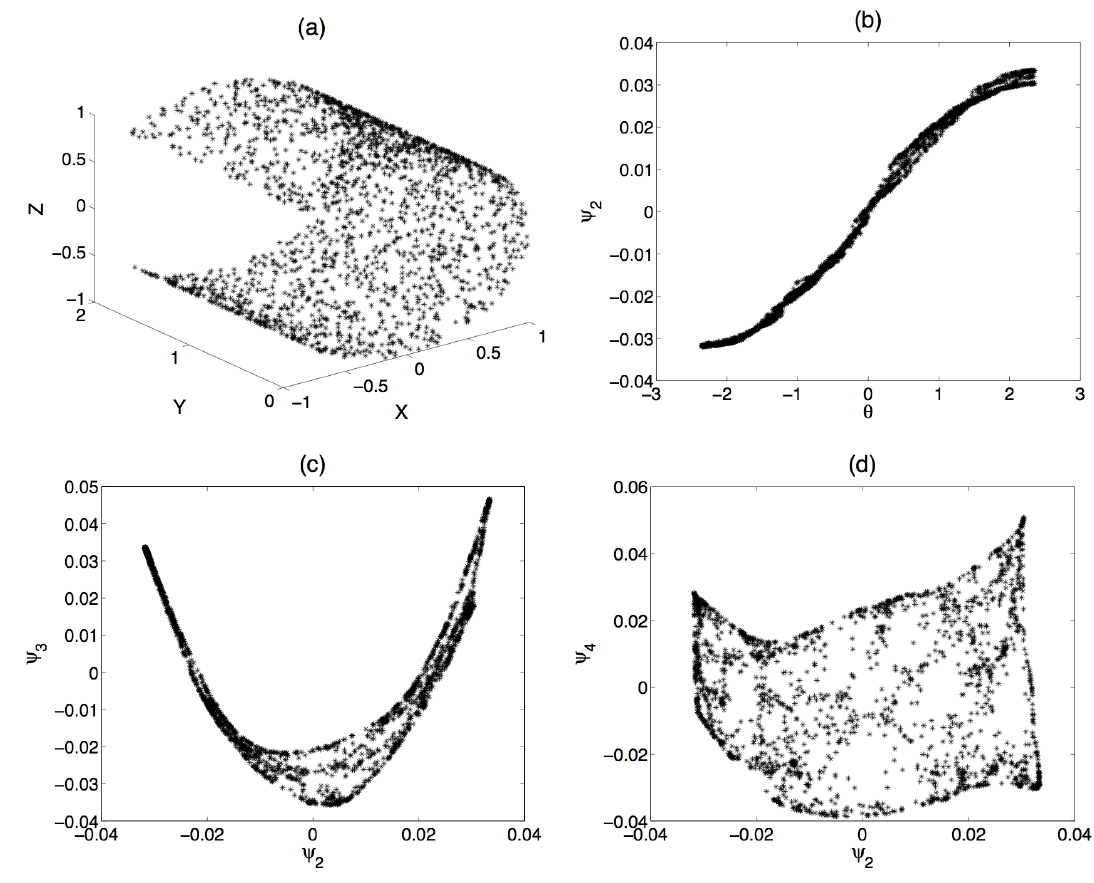
Figure 1. Data manifold, dimensionality and independence of DMAP eigenvectors ( a ) 2000 uniformly random points initially placed in a unit square are stretched and wrapped around three-fourths of a cylinder; ( b ) the entry in the first non-trivial eigenvector of the Markov matrix, K , vs . the first cylindrical coordinate, θ , for each data point; ( c ) entry in the second non-trivial eigenvector of K vs . the first one; the quasi-one-dimensionality of the plot implies strong eigenvector correlation; ( d ) entry in the third non-trivial eigenvector of K vs . the first one. The evident two-dimensional scatter implies that a new direction on the data manifold has been